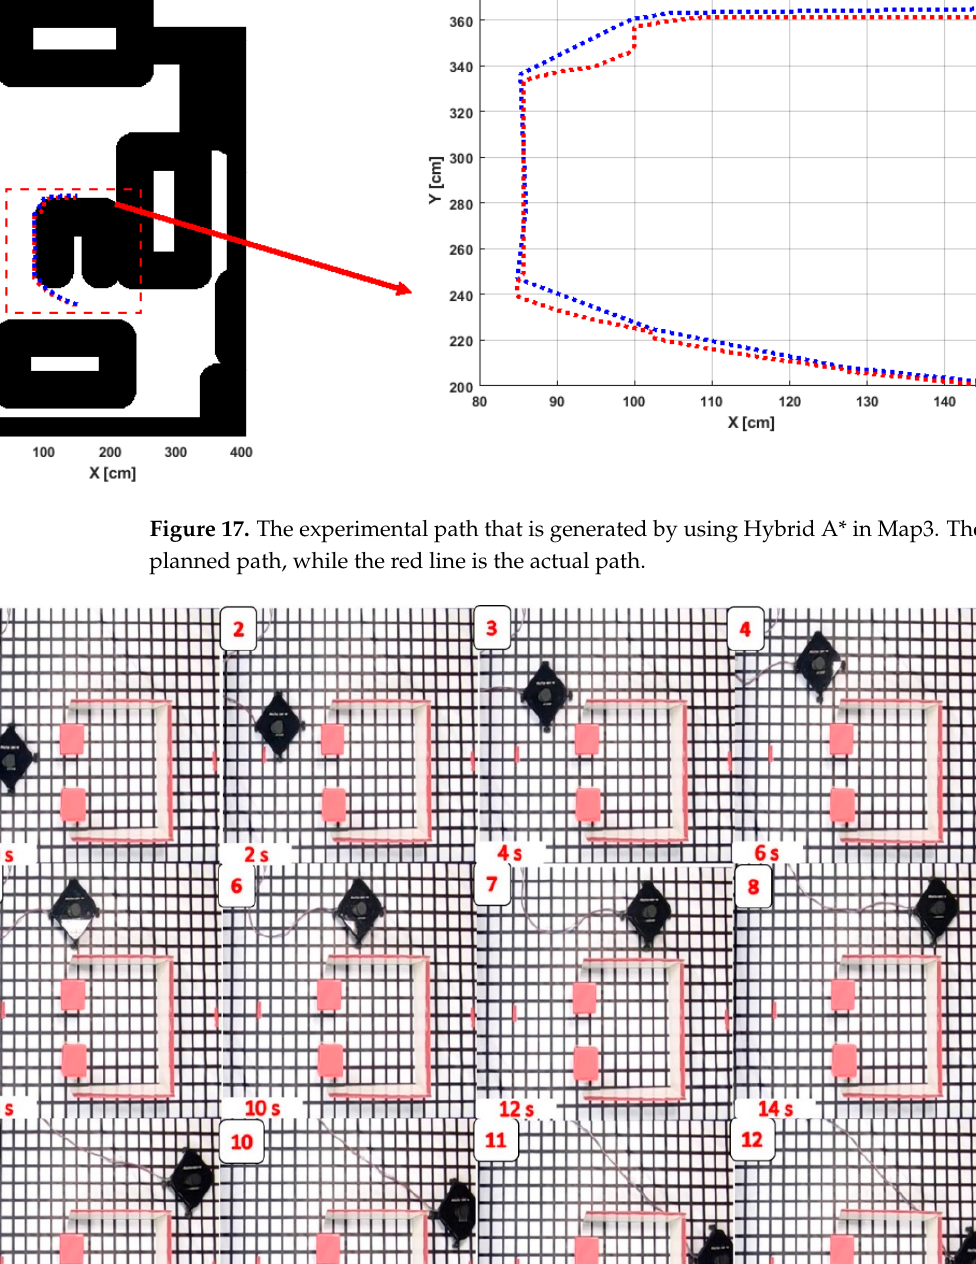
Figure 18. Screenshots for the experimental implementation of the Hybrid A* algorithm on the 4OWMR for Map3.